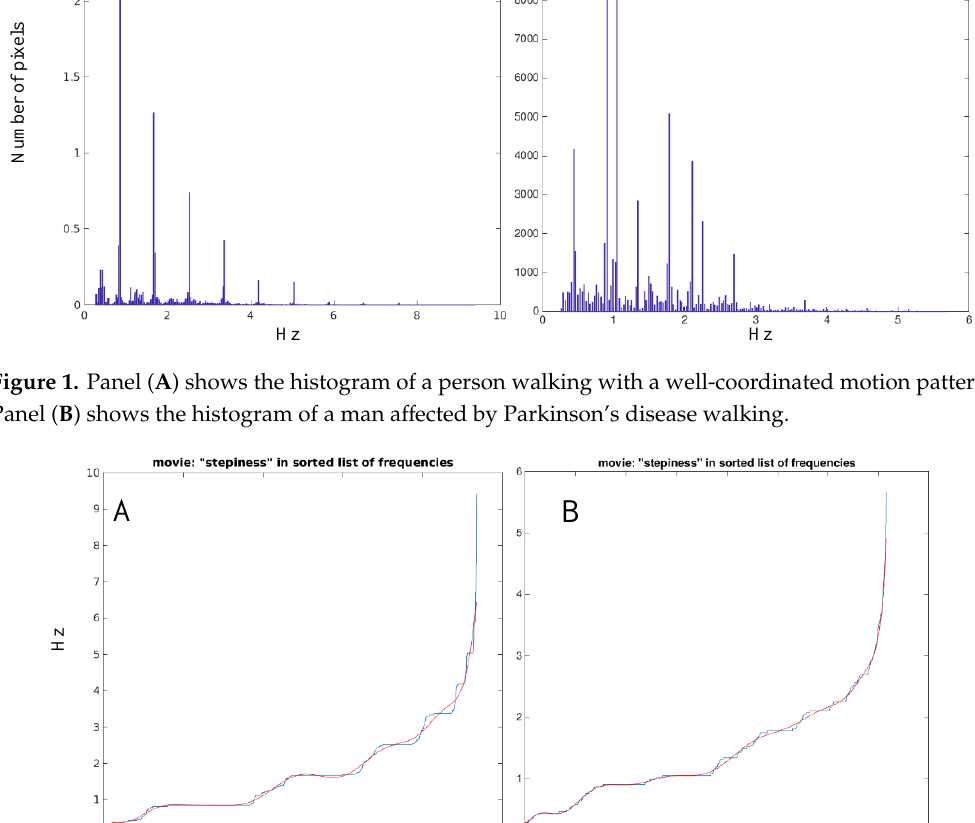
Figure 2. Figure ( A ) shows the “step plot” in blue and the polynomial fitting function in red of a man walking with a well-coordinated, “steppy”, motion pattern. Figure ( B ) shows the irregular, “smoother”, gait of a man affected by Parkinson’s disease. It is possible to observe less, well-demarcated frequency components in case A compared to many “blurred” components in case B.